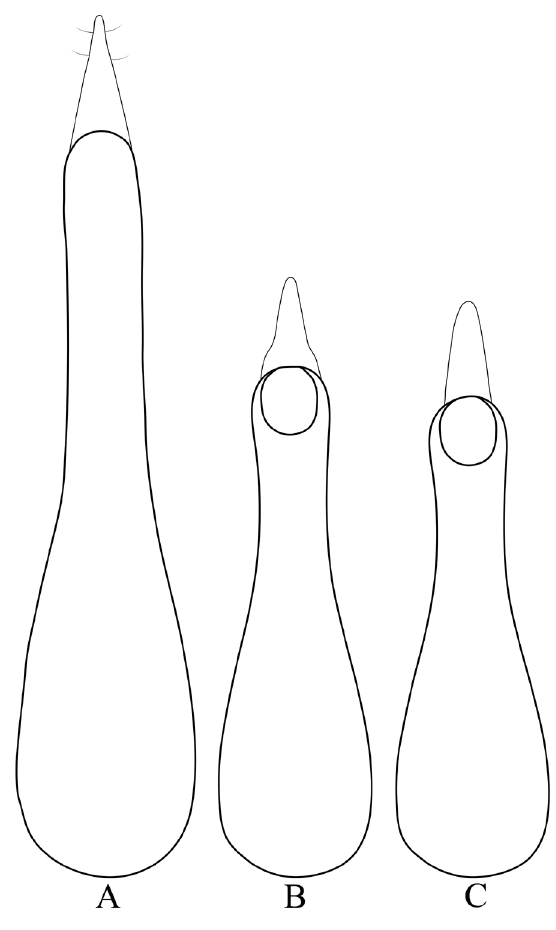
Figure 2. Aedeagi of Lord Howe Island Cheilocolpus (anti-parameral view). A Cheilocolpus olliffi sp. n. B C. castaneus (Lea, 1925) C C. kentiae (Lea, 1925).